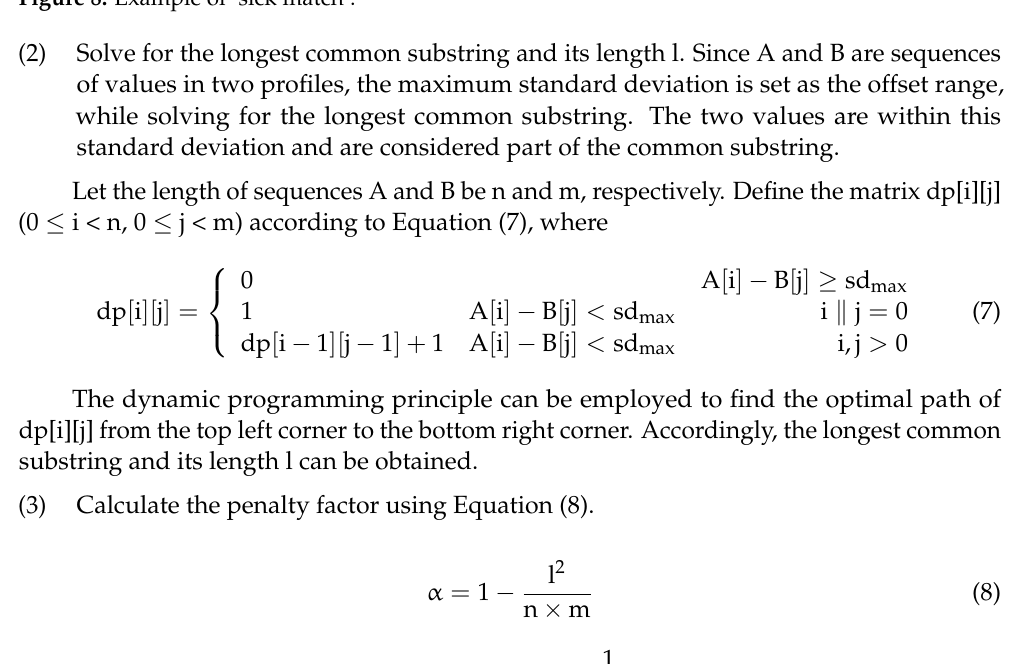
Figure 8. Example of ‘sick match’ .